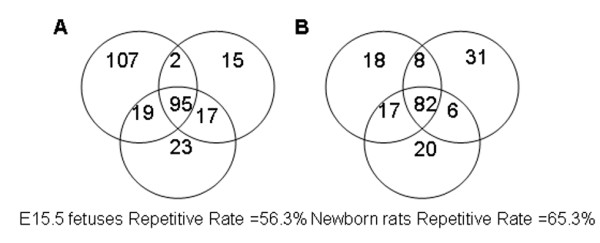
Repetitiveness of individual specimens.A and B indicate the repetitiveness of proteins identified in three E15.5 fetuses (A) and three newborn rats (B), respectively. Each circle in A and B represents an individual sample. The numbers represent the number of shared proteins in the respective overlapping areas. The repetitiveness of the individual specimens was evaluated based on the repetitive rate of protein identification (E15.5 fetuses, Repetitive Rate = 56.3%; newborn rats, Repetitive Rate = 65.3%).